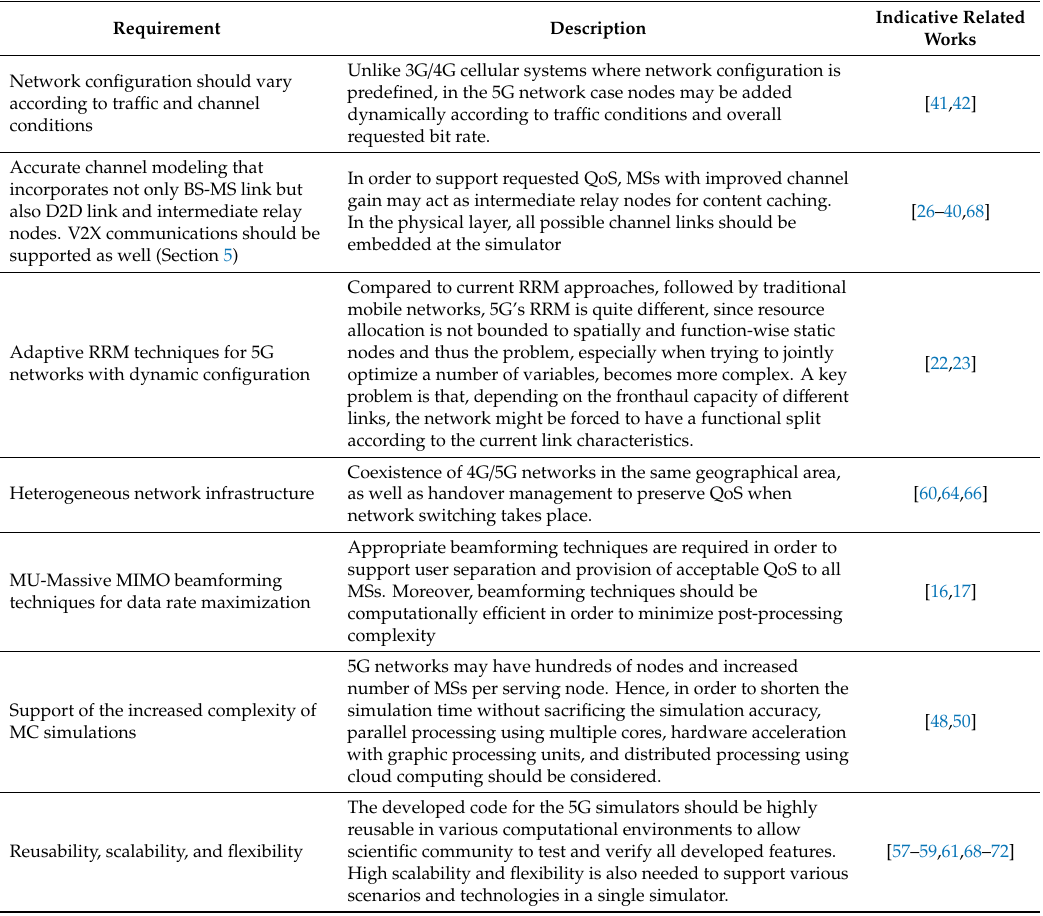
Table 1. Main requirements for 5G